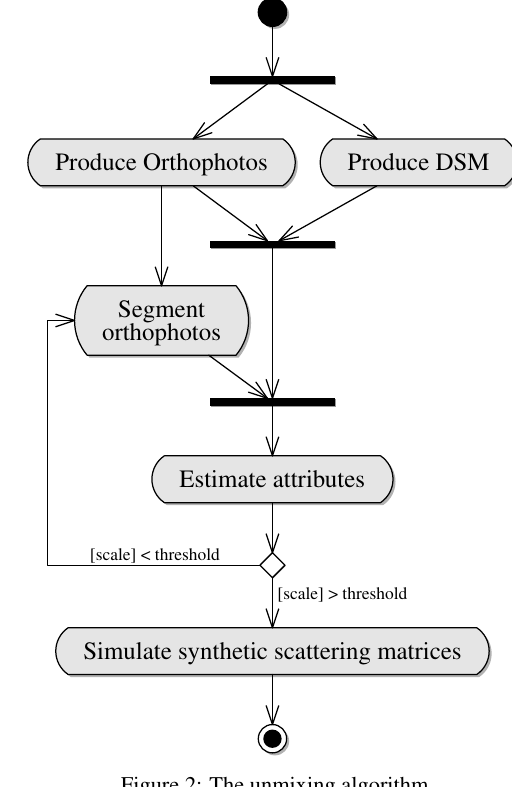
Figure 2: The unmixing